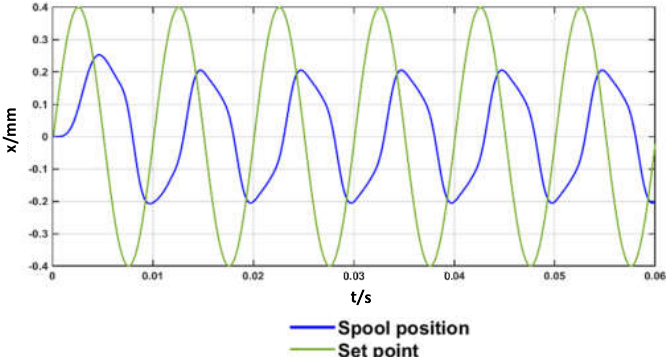
Figure 14. Sine wave response for input amplitude = 0.4 mm and frequency = 100 Hz ( p p − p T = 70 bar, C p = 90 Ns/m, m p = 80 g; ω n , a = 1400 rad/s): spool position vs. time.